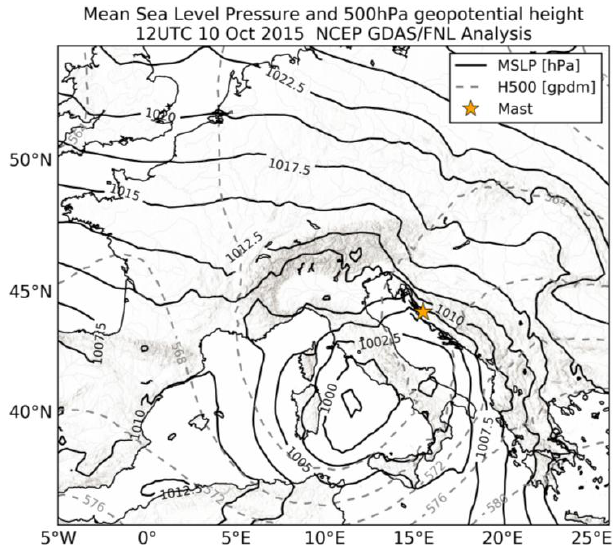
Figure 3. The surface analysis (NCEP GDAS/FNL) mean sea level pressure (solid line) and geopotential height at 500 hPa (dashed line) for 12 UTC on 10 October 2015. The bora episode B01 (SC). The measurement site is marked with the orange star.